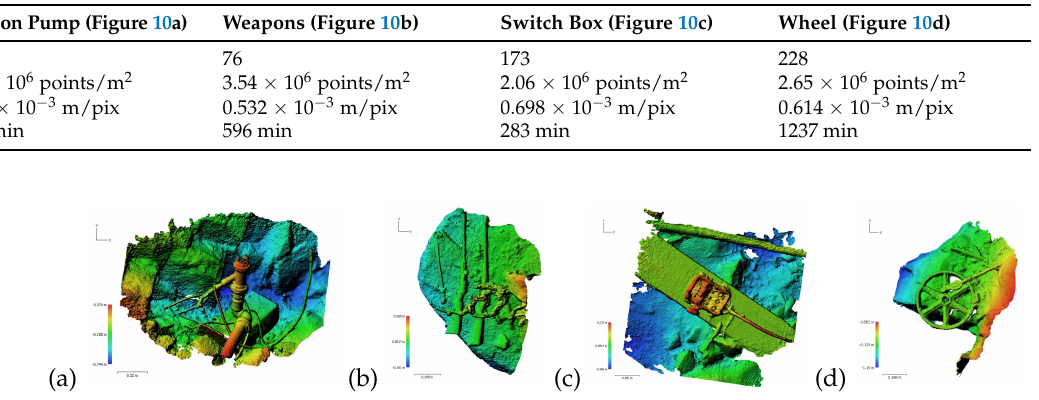
Figure 10. Reconstructed underwater object ( a ) injection pump, ( b ) weapons, ( c ), switch box, and ( d ) wheel with the scale and the local coordinate